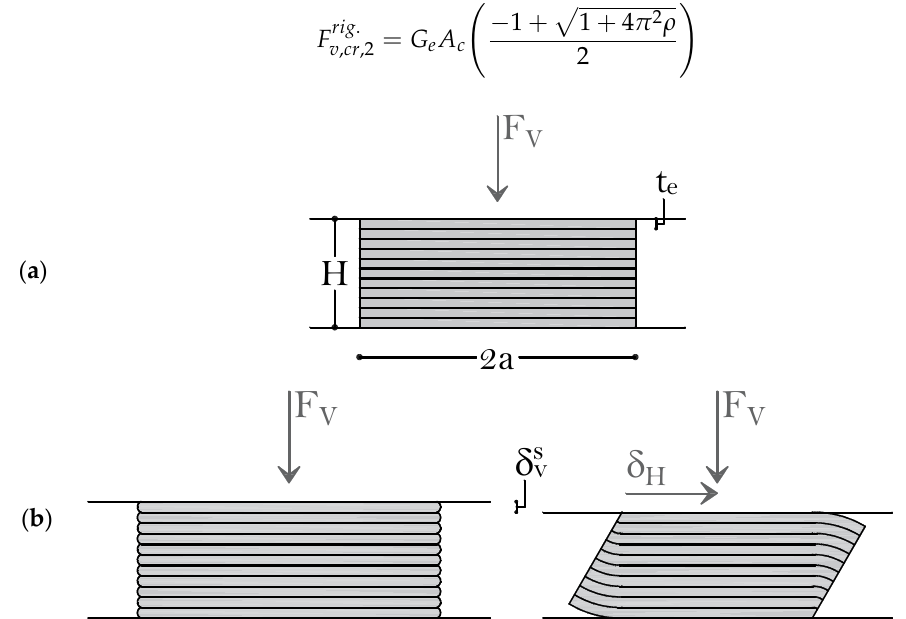
Figure 1. ( a ) Definition of the geometric parameters for a strip-shaped U-FREI under a compressive load; ( b ) vertical displacement due to horizontal displacement of a strip-shaped U-FREI (adapted from [43]).